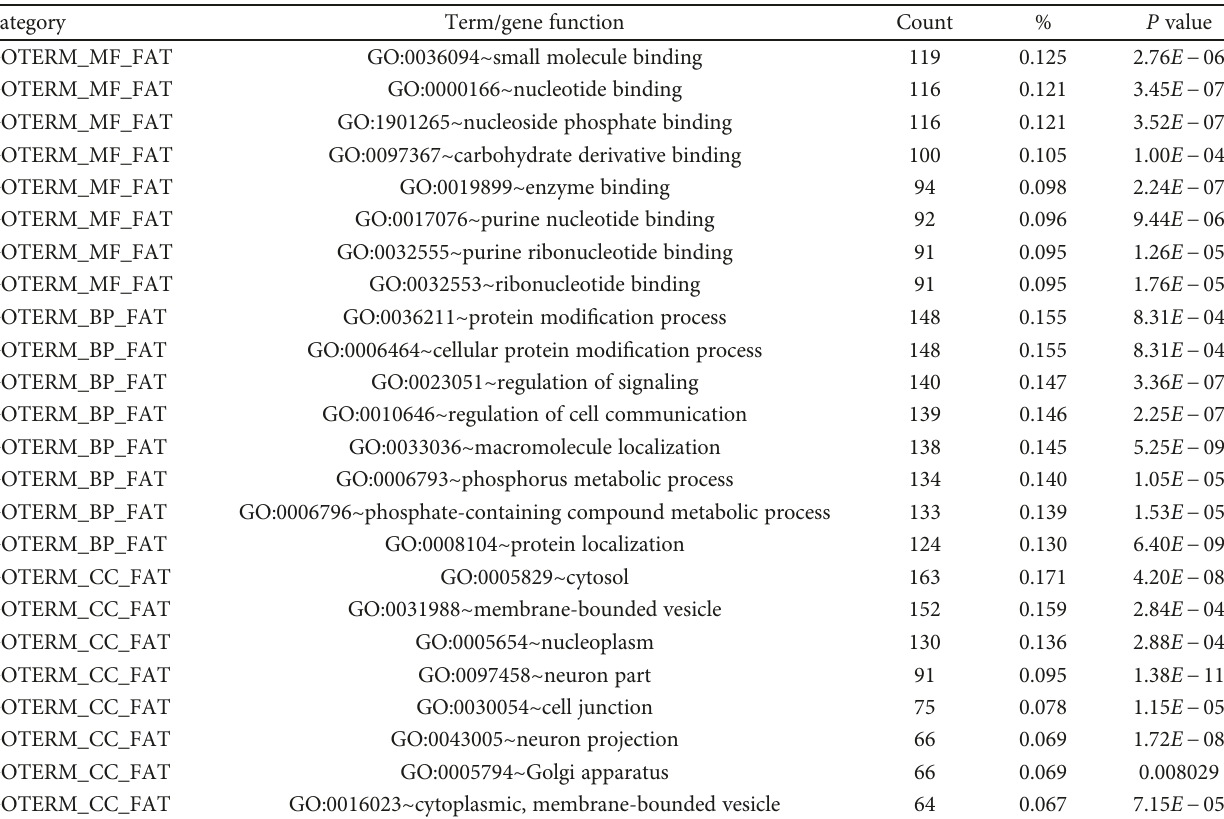
3.3. KEGG Pathway Analysis. The signi fi cant enriched path- ways of the downregulated DEGs, analyzed by KEGG analy- sis, are shown in Table 2. The downregulated genes were enriched in the MAPK signaling pathway, endocytosis, oxy- tocin signaling pathway, calcium signaling pathway, proteo- glycans in cancer, purine metabolism, cAMP signaling pathway, and regulation of the actin cytoskeleton.